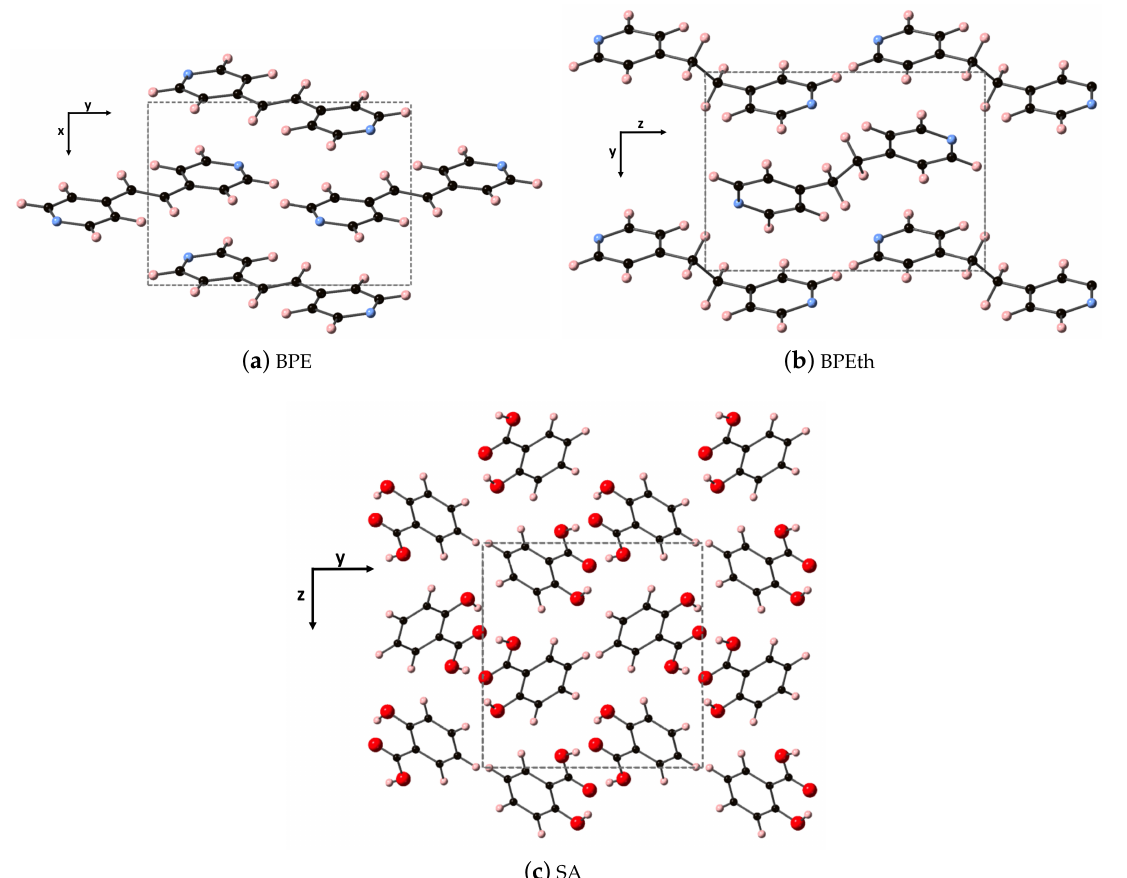
Figure 1. Shown here are the co-crystal components ( a ) BPE, ( b ) BPEth, and ( c ) SA. Atoms of carbon, hydrogen, nitrogen, and oxygen are depicted as black, light pink, light blue, and red spheres, respectively. Dashed lines represent the crystallographic axes of the primitive lattice unit cell for each of the components.